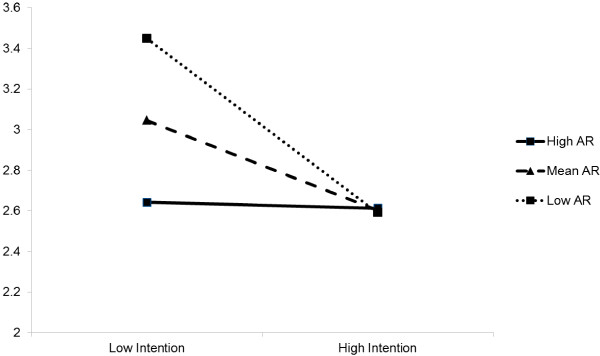
Interaction between anticipated regret (AR) and intention on OCP non-adherence (higher scores on the y axis relate to more non-adherence to OCP).